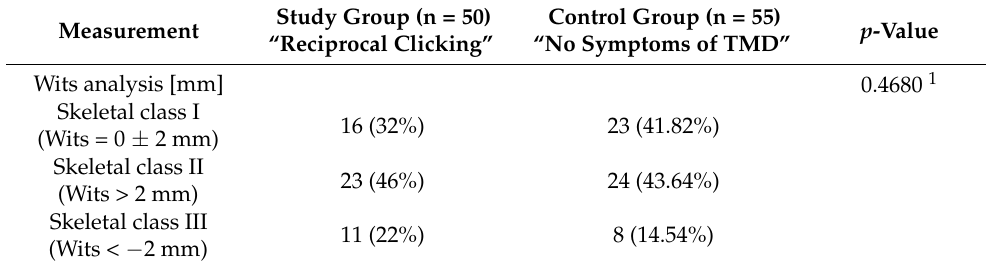
Table 5. Distribution of skeletal classes between the examined groups.